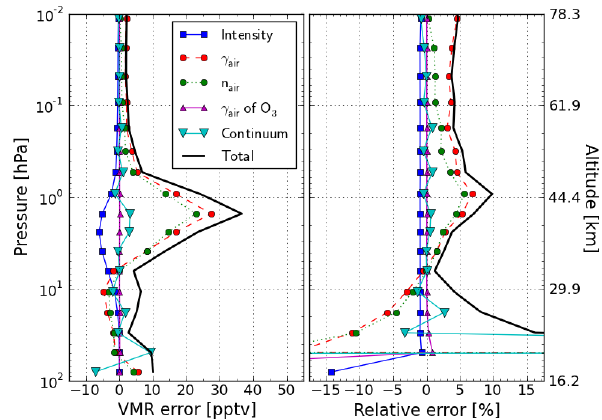
Fig. 5. Same as Fig. 4 except for the errors from the spectroscopic parameters. Blue: +1% uncertainty in line intensity, red: +3% uncertainty in γ air , and green: +10% uncertainty in n air of the ClO transitions at 649.445 and 649.451GHz. Purple: +3% uncertainty in γ air for the O 3 transition at 650.732GHz. Cyan: +20% uncertainty in the dry-air continuum. Black: Total error for the five components.